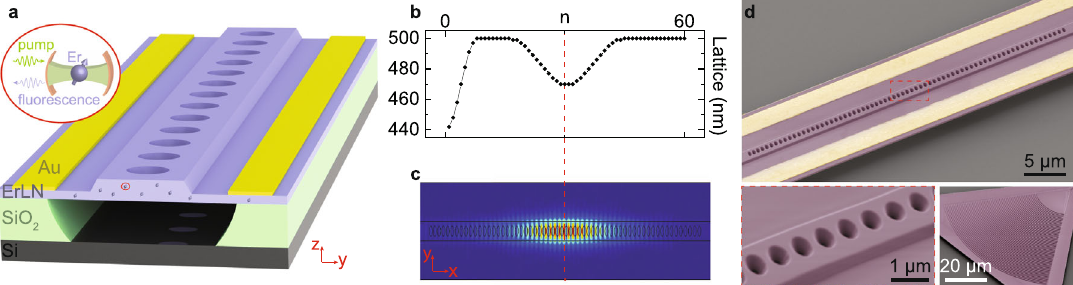
Fig. 1 | Device design. a Schematic drawing of our device (not to scale). Periodic holes are patterned on a suspended ridge waveguide to form photonic crystal mirror. Gold electrodes are deposited along the waveguide for electro-optic fre- quency tuning. Erbium (Er) ions are uniformly distributed in lithium niobate (LN). Ions in the photonic cavity can be addressed by collecting fl uorescence. b